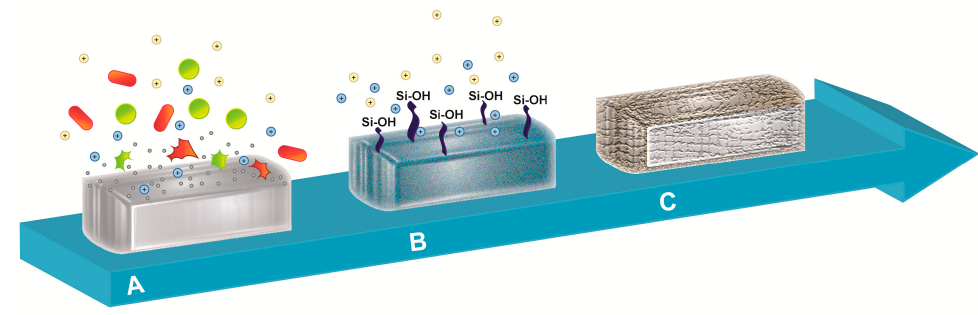
Figure 1. Schematic representation of the reaction upon body fluids contact. The illustration represents ( A ) the leak of ions triggered by the interaction of bioactive glass with body fluid, resulting in bactericidal action against microorganisms, followed by ( B ) the formation of a silica-based layer mediated by the generation of silanol (Si–OH) surface groups and ( C ) the final coating of bioactive glass granule with a mixed carbonated hydroxyapatite layer.